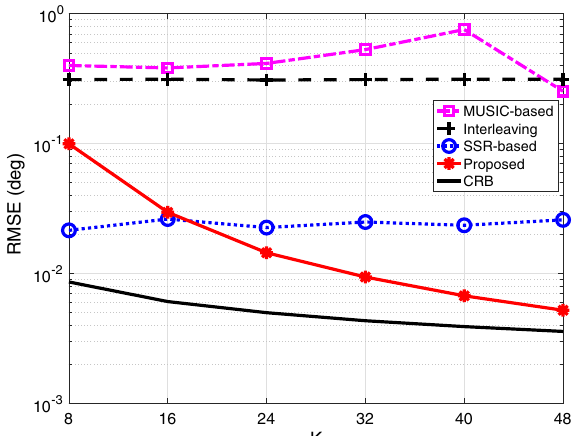
Fig. 5 DOA estimation accuracy comparison with different number of